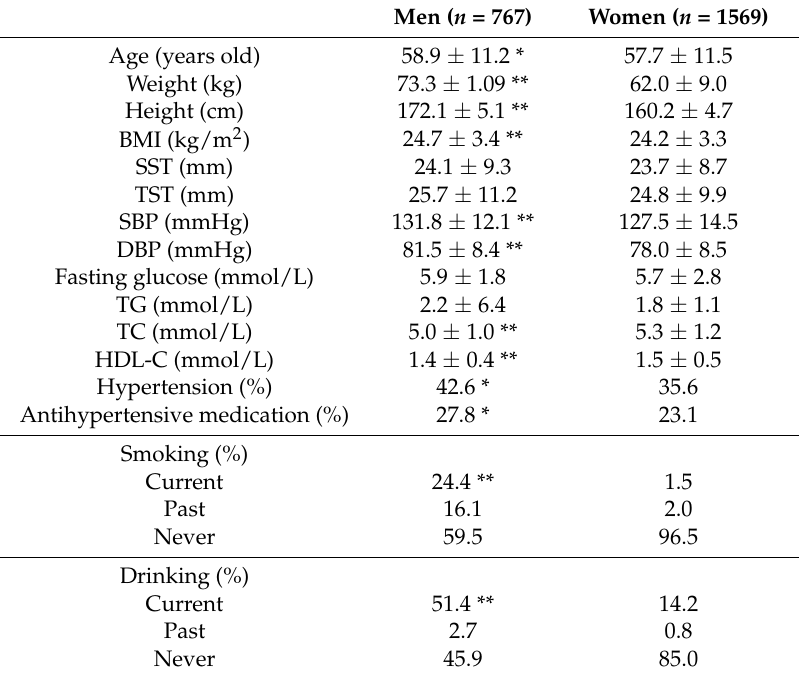
Table 1. Baseline characteristics of participants from Shenhe District, Liaoning Province, China (2336 participants, aged 20 to 94 years old, examined in